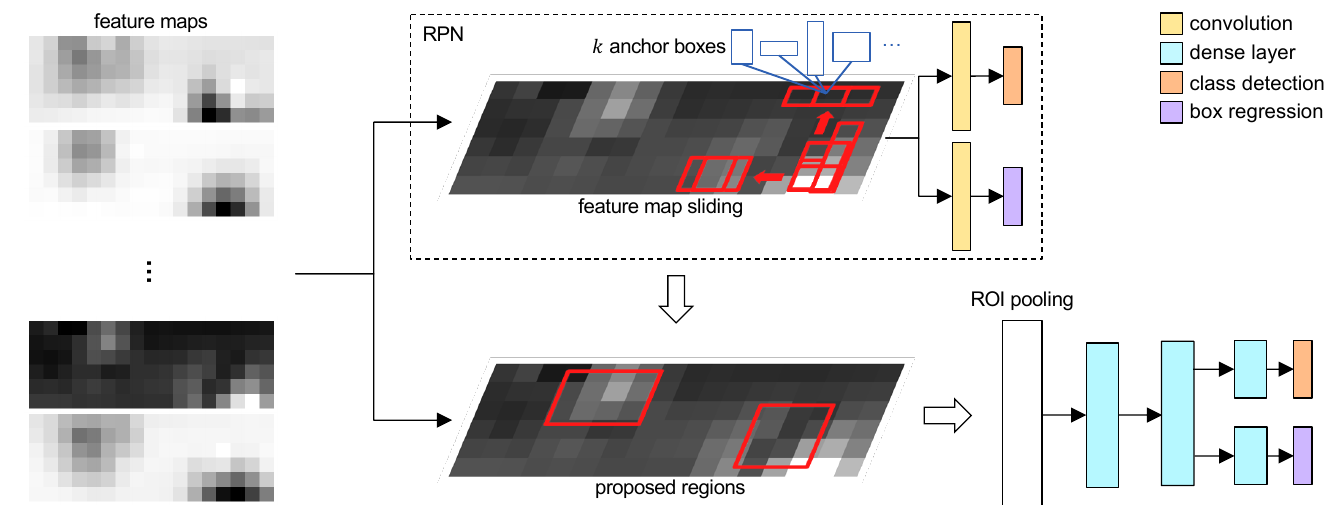
Figure 4. Faster R-CNN RPN and ROI pooling